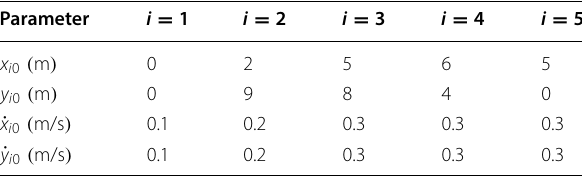
Table 1 Initial conditions